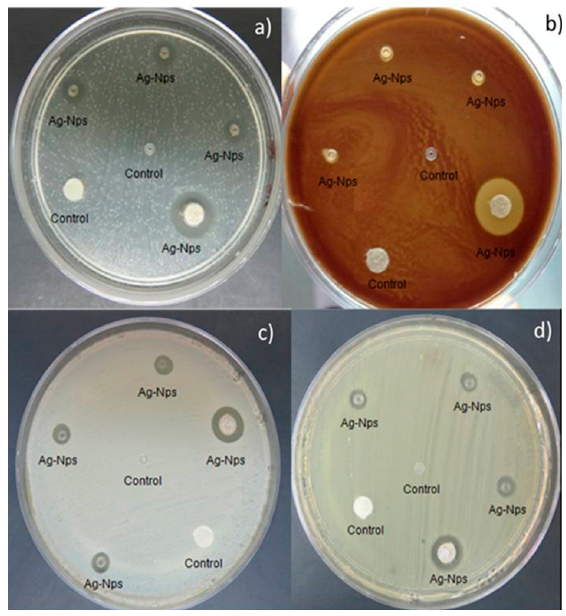
Figure 5. Antibacterial activity of samples in the agar diffusion test. Ag-NPs showed inhibition halos for ( a ) Streptococcus mutans ; ( b ) Lactobacillus casei ; ( c ) Stsphylococcus aureus ; ( d ) Escherichia coli . Table 1. Inhibition zone (mm).